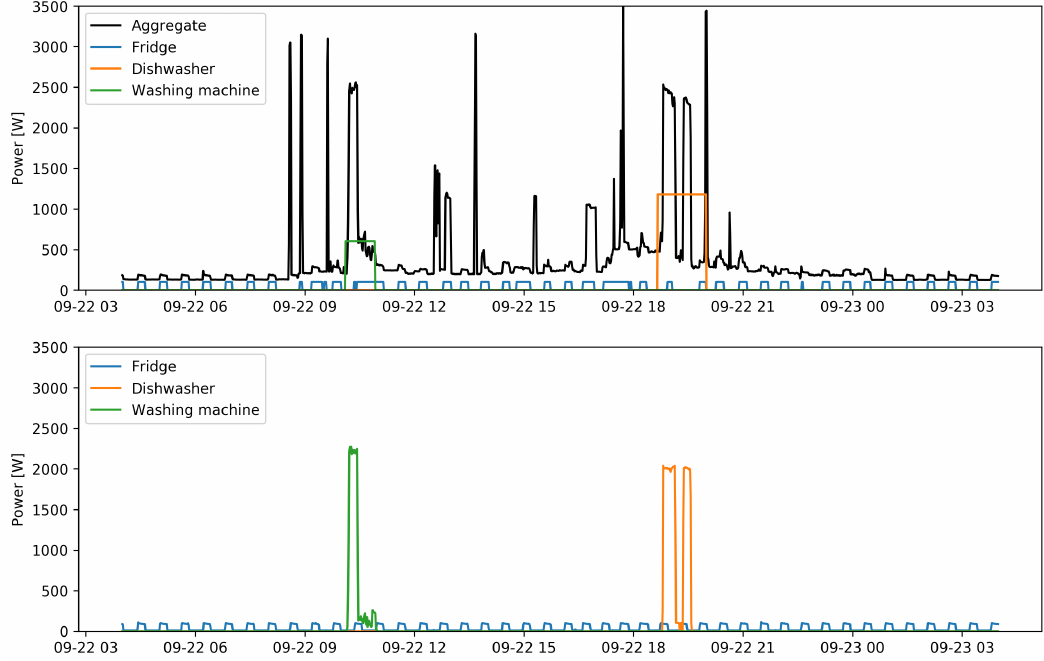
Figure 3. Example of load disaggregation for the unseen case. The upper graph shows the aggregate load and the estimated consumption obtained by the method, while the lower graph shows true values of the power absorbed by the three appliances. The estimated value of the consumption of household appliances in the upper part of the figure is assumed to be constant for the activation periods and equal to the average consumption during